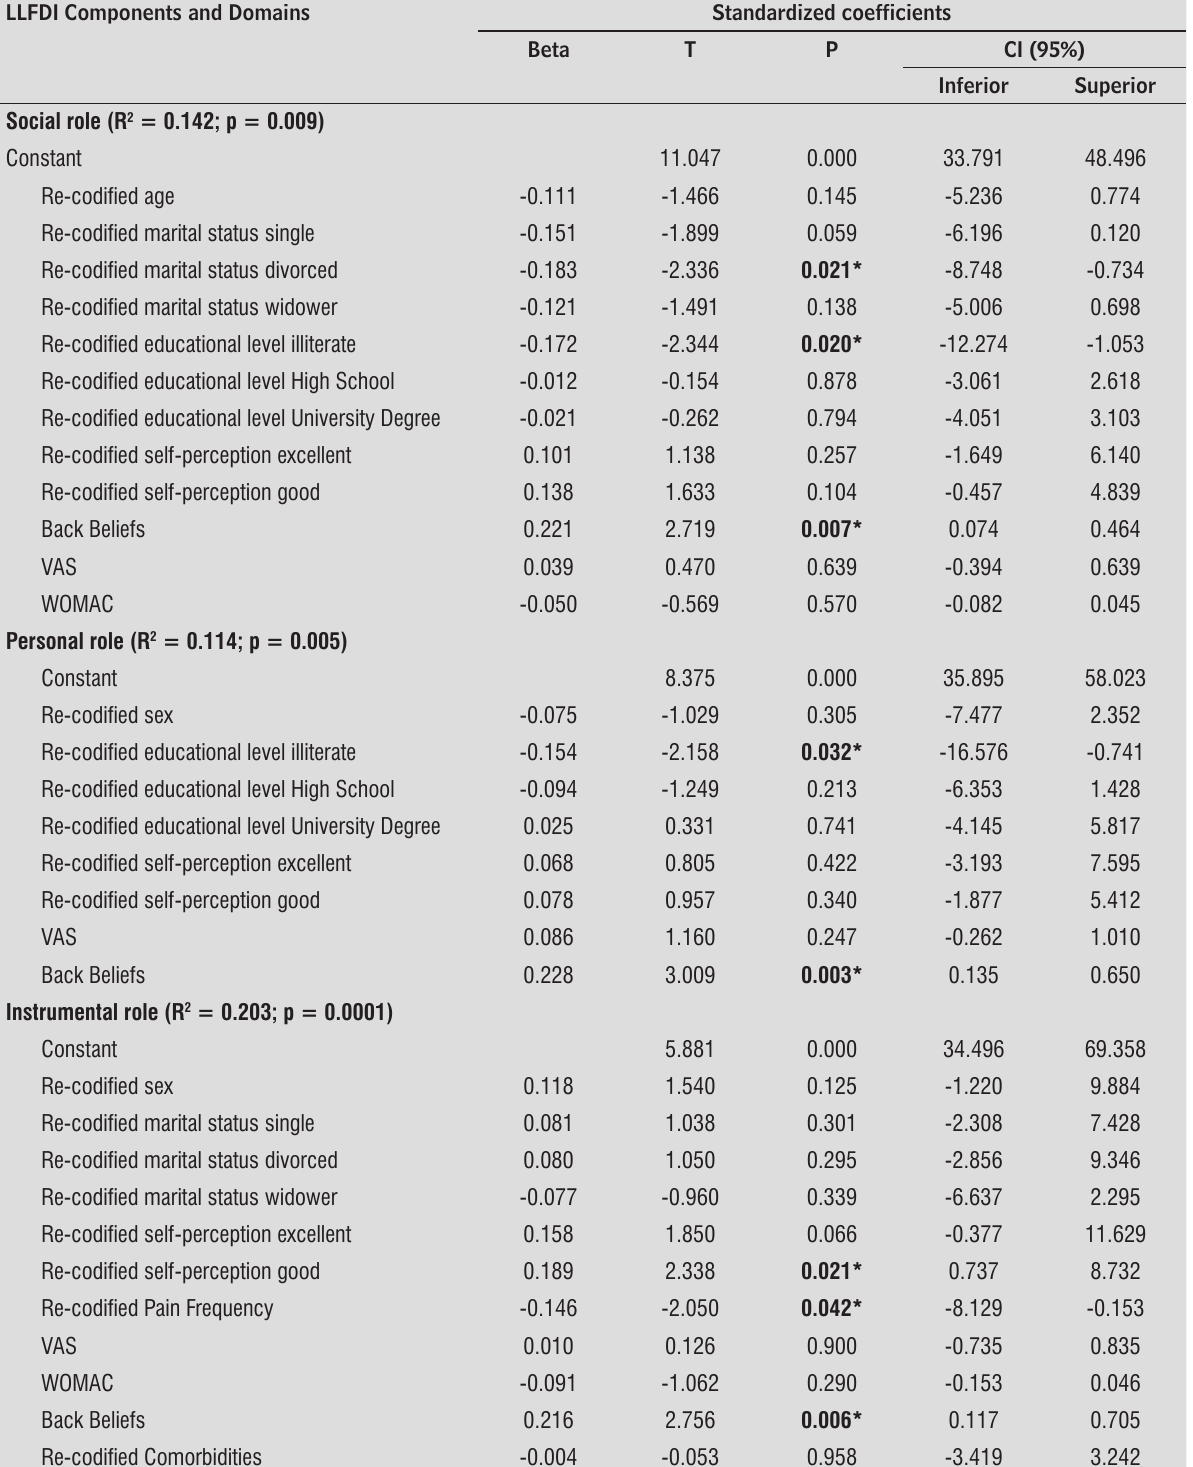
Table 4 - Multiple linear regression models of factors associated with LLFDI dimensions and areas LLFDI Components and